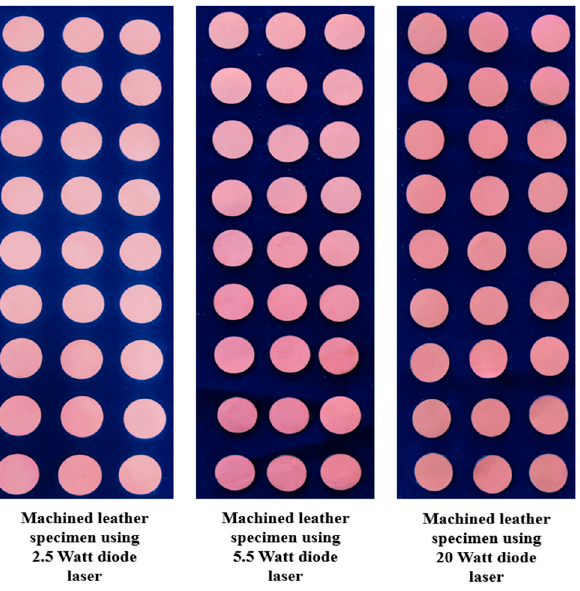
Figure 1. Machined bu ff alo leather samples.